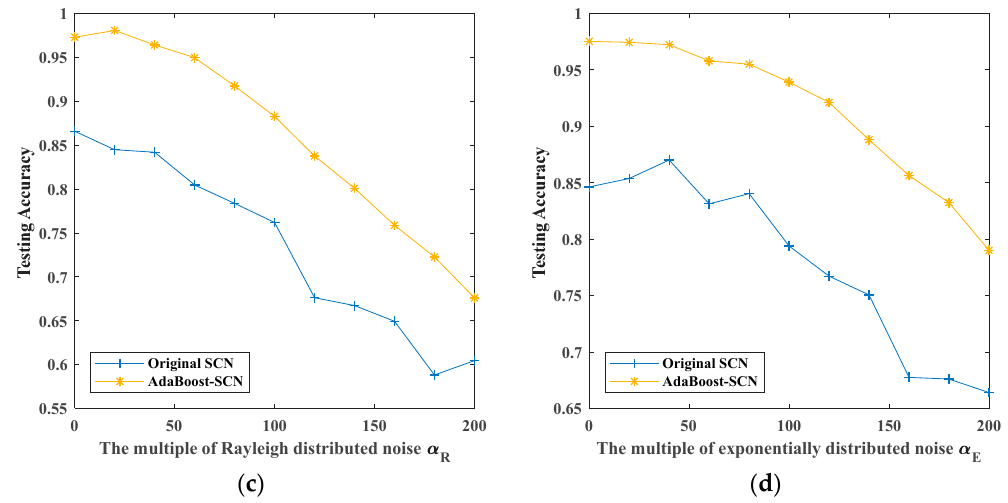
Figure 13. The maximum testing accuracy of original SCN and AdaBoost-SCN with different noises: ( a ) white Gaussian noise; ( b ) white uniform noise; ( c ) Rayleigh distributed noise; ( d ) exponentially distributed noise.